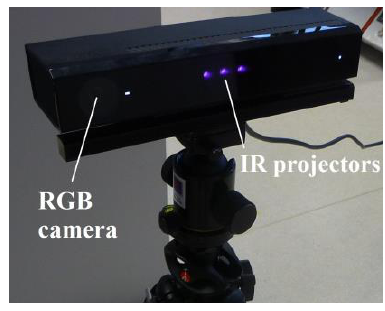
Figure 1. Kinect v2 sensor on a photographic tripod The RGB camera captures color information with a resolution of 1920x1080 pixels, whereas the IR camera is used for the real-time acquisition of depthmaps and also IR data with a 512x424 pixels resolution. The whole acquisitions can be carried out with a framerate up to 30 Hz. A last feature to be mentioned is the field of view for depth sensing of 70 degrees horizontally and 60 degrees